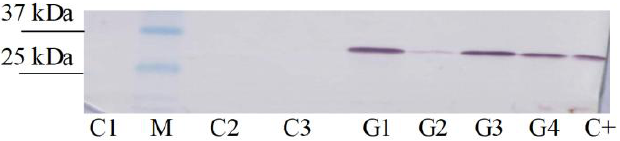
Figure 4. Western blot analysis for CVB of protein samples from the leaves of non-transgenic chrysanthemum plants after infection using grafting. C1–C3—non-transgenic non-infected plants. G1–G4—non-transgenic plants grafted with infected shoots after two-month growth in the greenhouse. M—molecular size marker. C+—CVB positive control (Loewe Biochemica, Sauerlach, Germany).